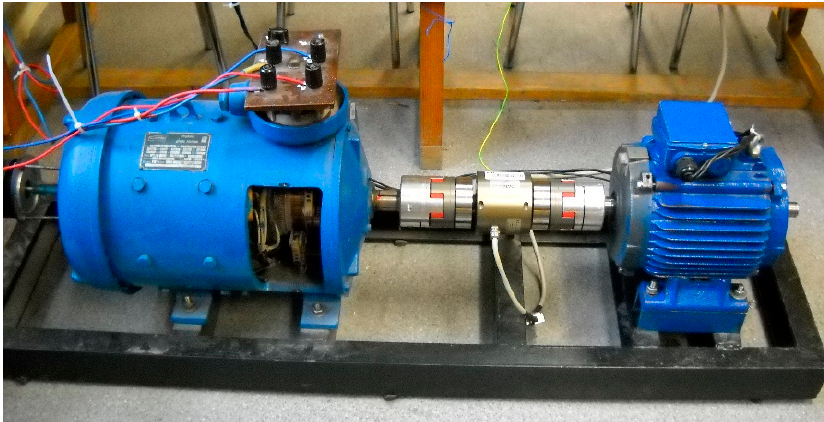
Figure 13. Laboratory testbench for diagnostic tests.